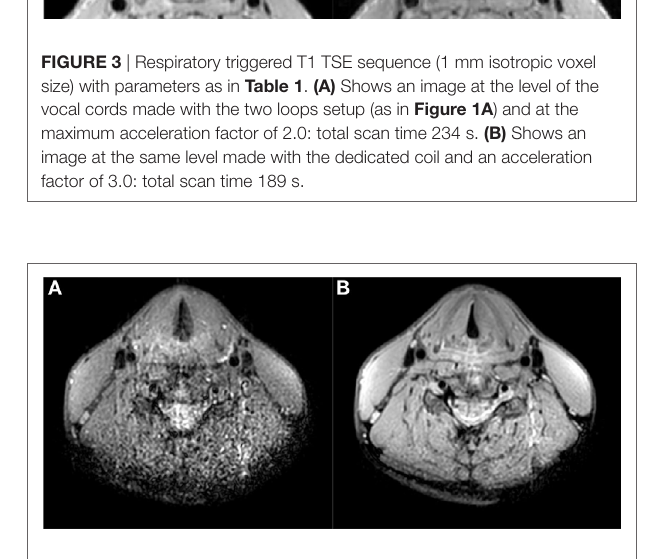
FIgURe 4 | T1 TSE multi-slice sequence (transversal) at 1.0 mm isotropic resolution with SPIR fat suppression (scan parameters in Table 1 ) (A) without respiratory trigger, duration 57 s, (B) with respiratory trigger, duration 216 s. Triggering mitigates breathing and swallowing motion artifacts and increases image quality.